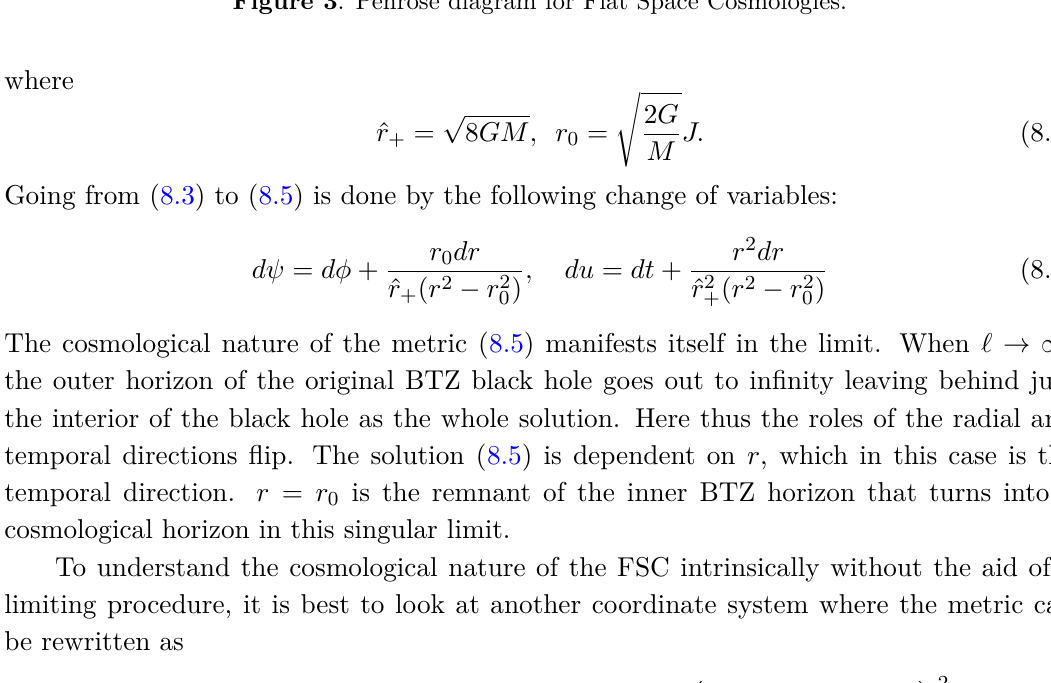
Figure 3 . Penrose diagram for Flat Space